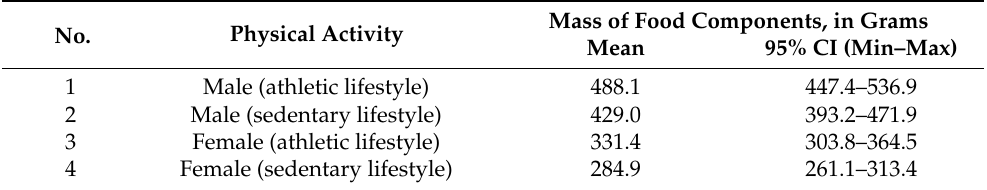
Table 4. Calculated values of the mass of food products and components with ARA required for the utilization of generated free